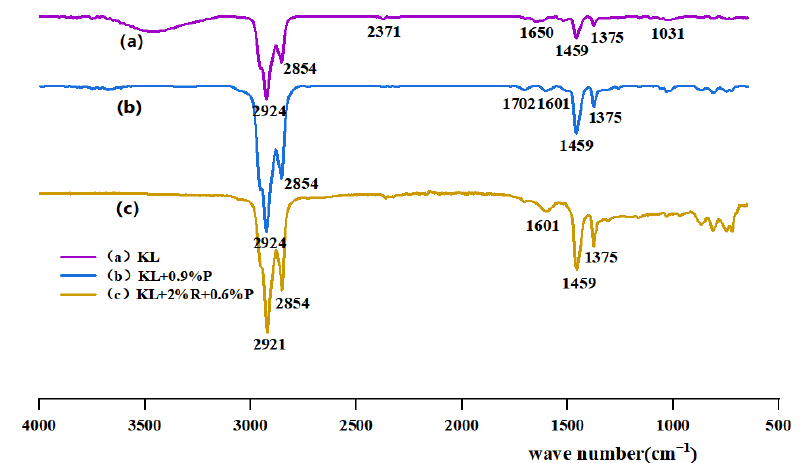
Figure 4. Infrared spectra of DH and its modified asphalts.